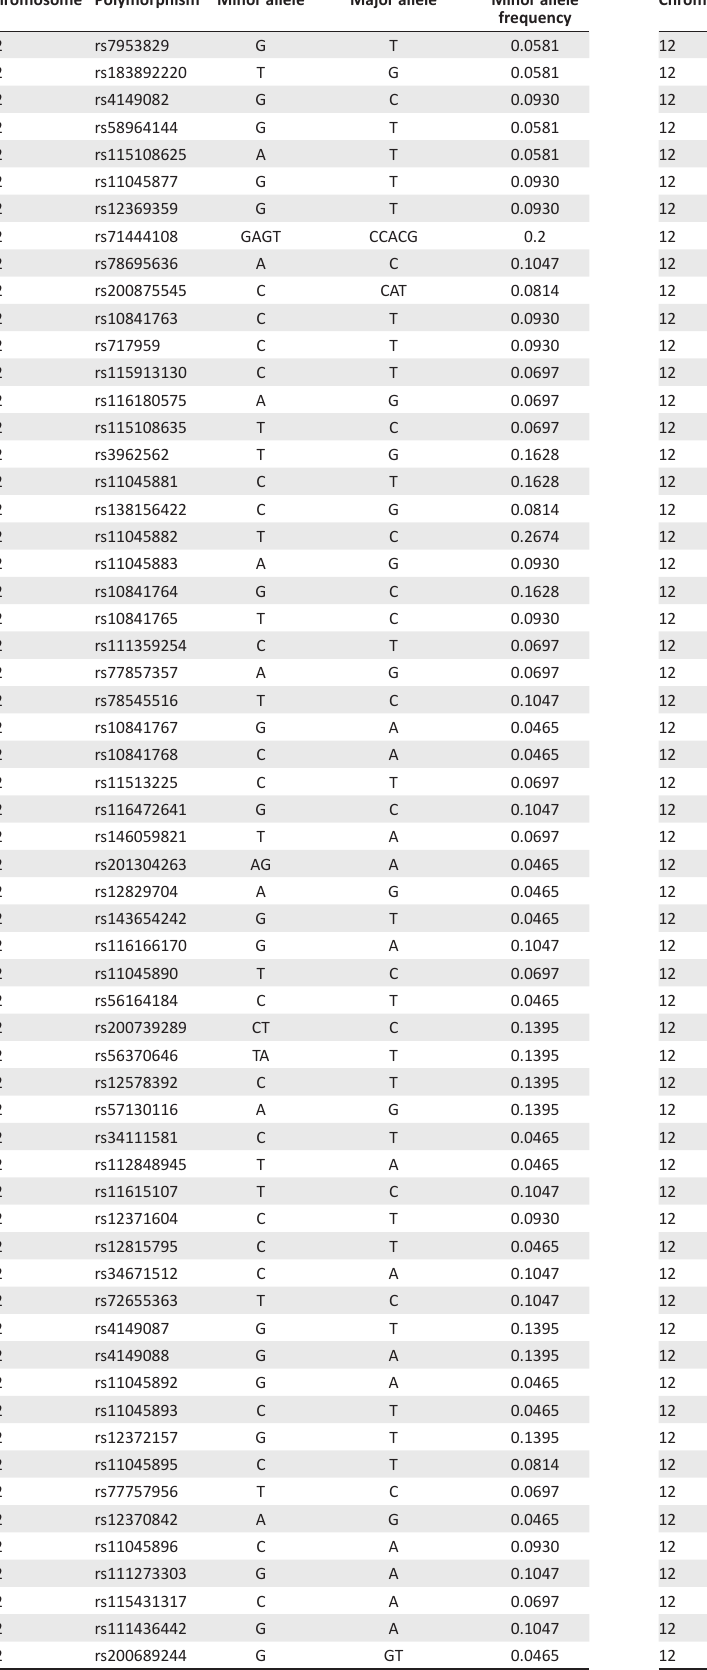
Table 1-A1 (Continues...): Minor allele frequencies for 1846 polymorphisms in 43 black South Africans. Chromosome Polymorphism Minor allele